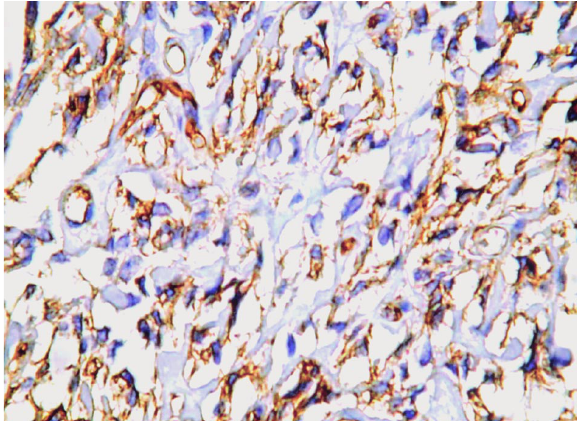
Figure 4 – Photomicrography of immunohistochemical exam, showing strong positivity of tumor cells to antibody anti-CD34